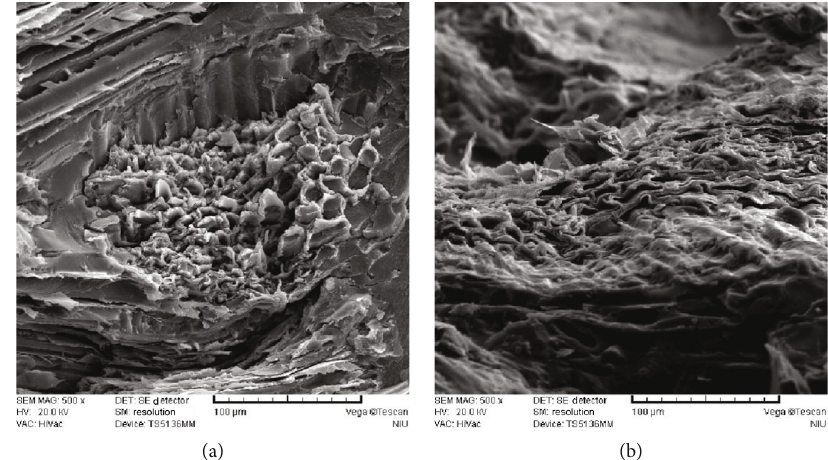
Figure 15: SEM graph of PU(PPG 700)-EP graft-IPNs added modi fi ed sugarcane bagasse (500x), bioadditive content: (a) 30 wt%; (b)